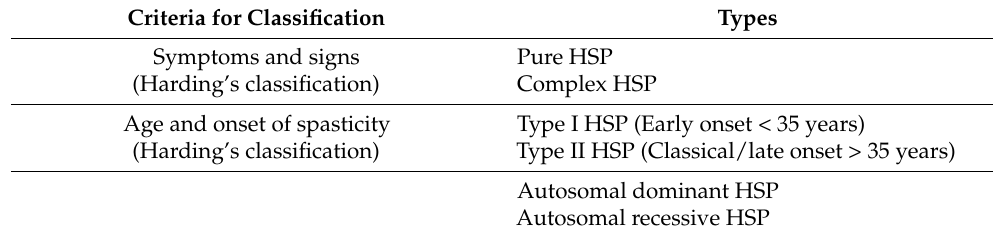
Table 2. Classification of HSP. Criteria for